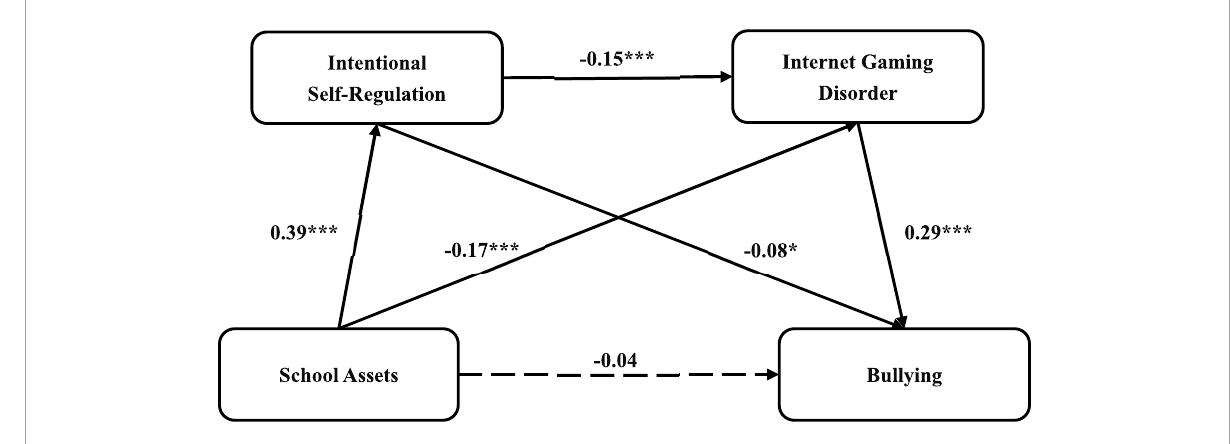
FIGURE2 The serial multiple mediation model between school assets and bullying. * p < 0.05, *** p < 0.001.